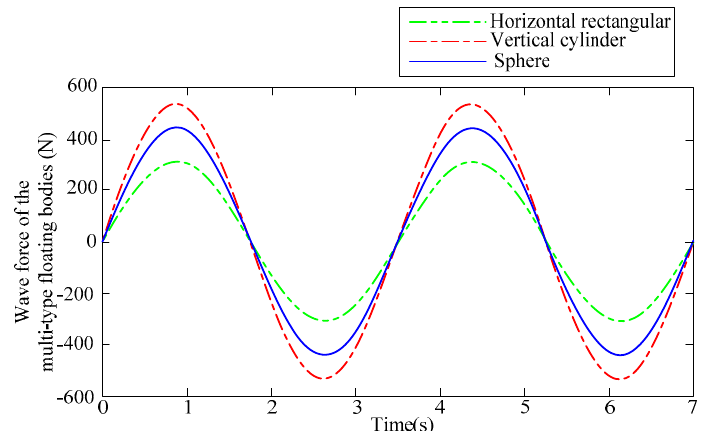
Figure 4. The wave force of the multi-type floating bodies ( H = 0.3 m, T = 3.5 s).